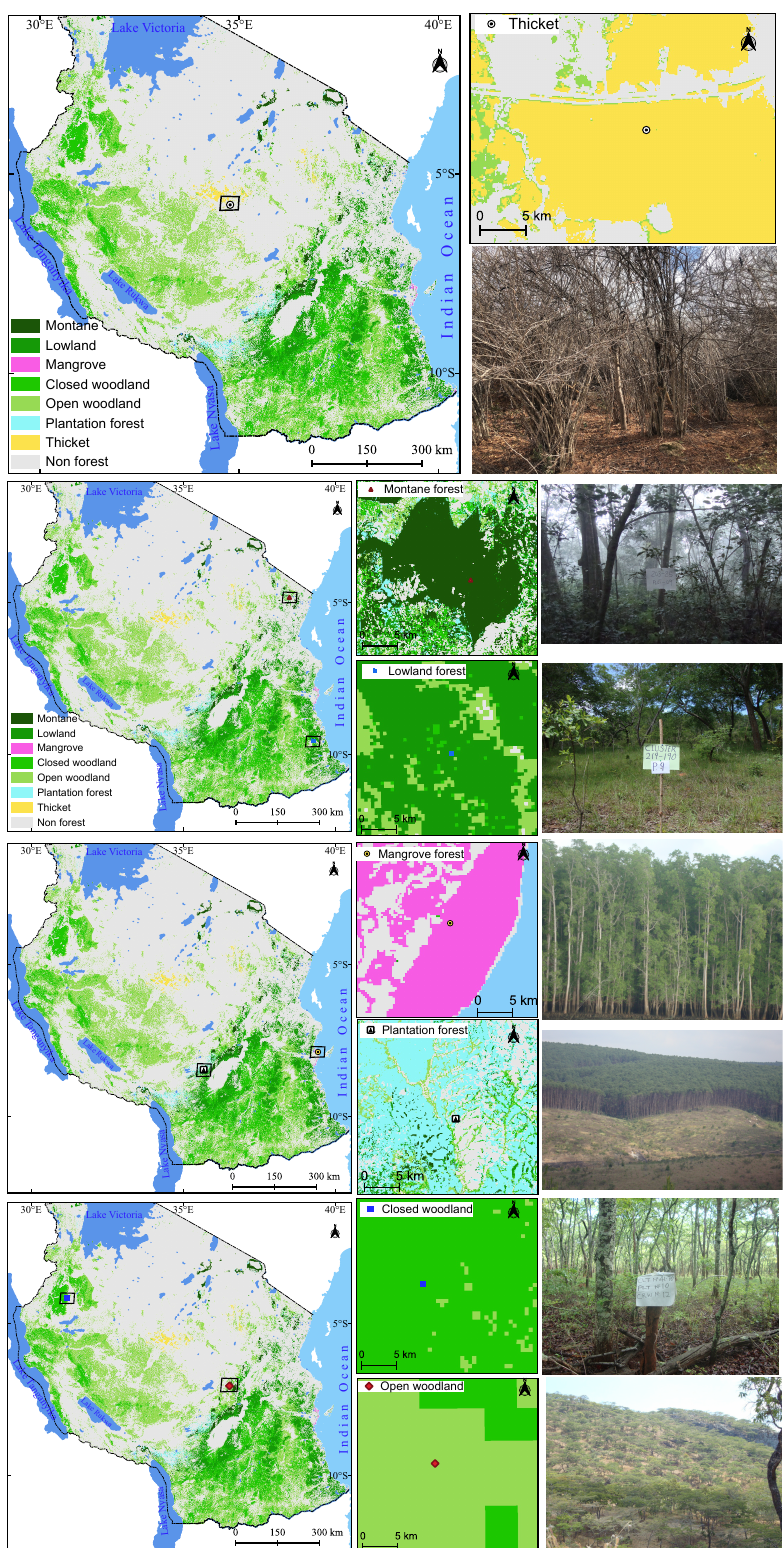
Figure 6. A set of examples sites, with field photos, illustrating the classification result and forest types. These examples demonstrate the complex nature of these forests and the local quality of the resulting classification (photos acquired by